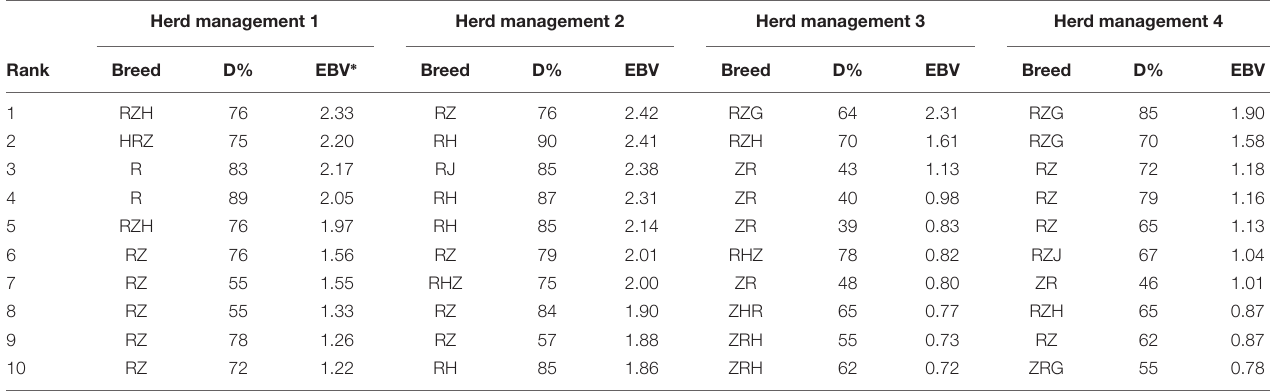
TABLE 6 | The top 10 cows in breeding values for milk yield in each management group with their percentage dairyness and breed composition. Herd management